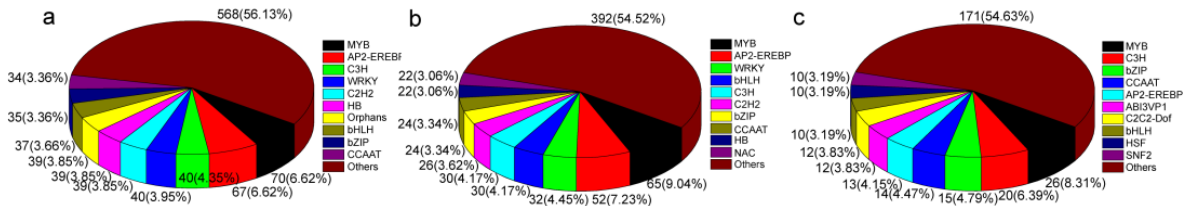
Figure 5. Classification and distribution of transcription factors in response to cut-wounding at different times. ( a ), ( b ), and ( c ), 4 h, 12 h, and 24 h after cutting, respectively.